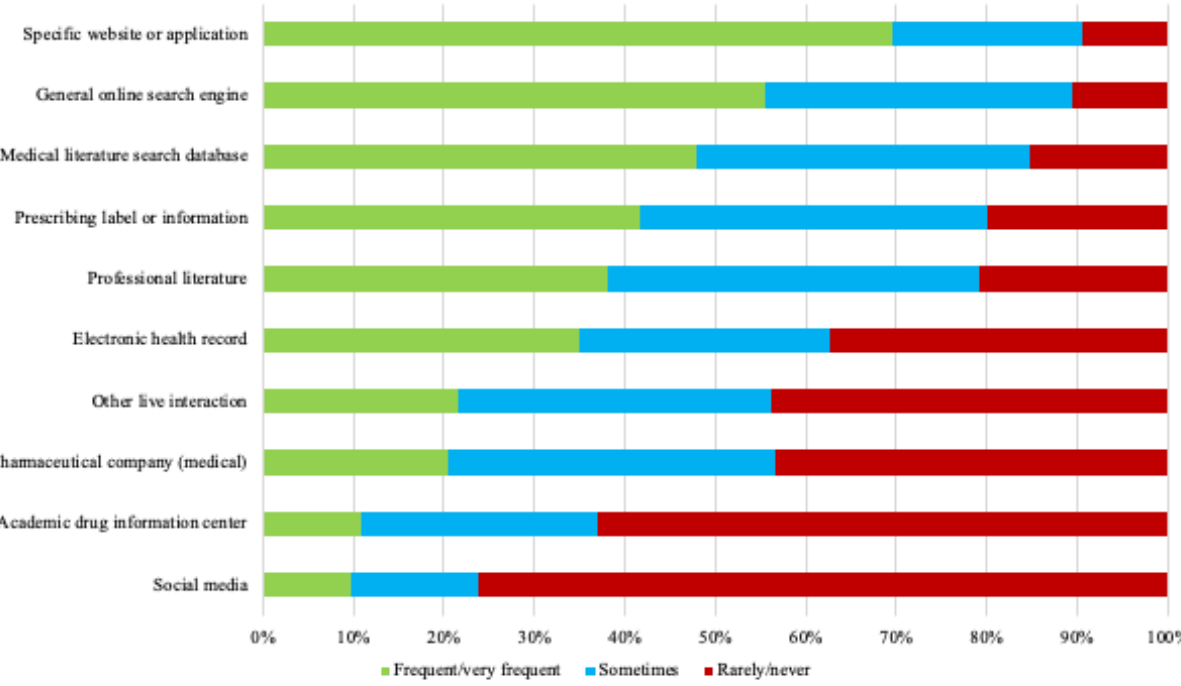
Figure 3. Frequency of use of major information sources.